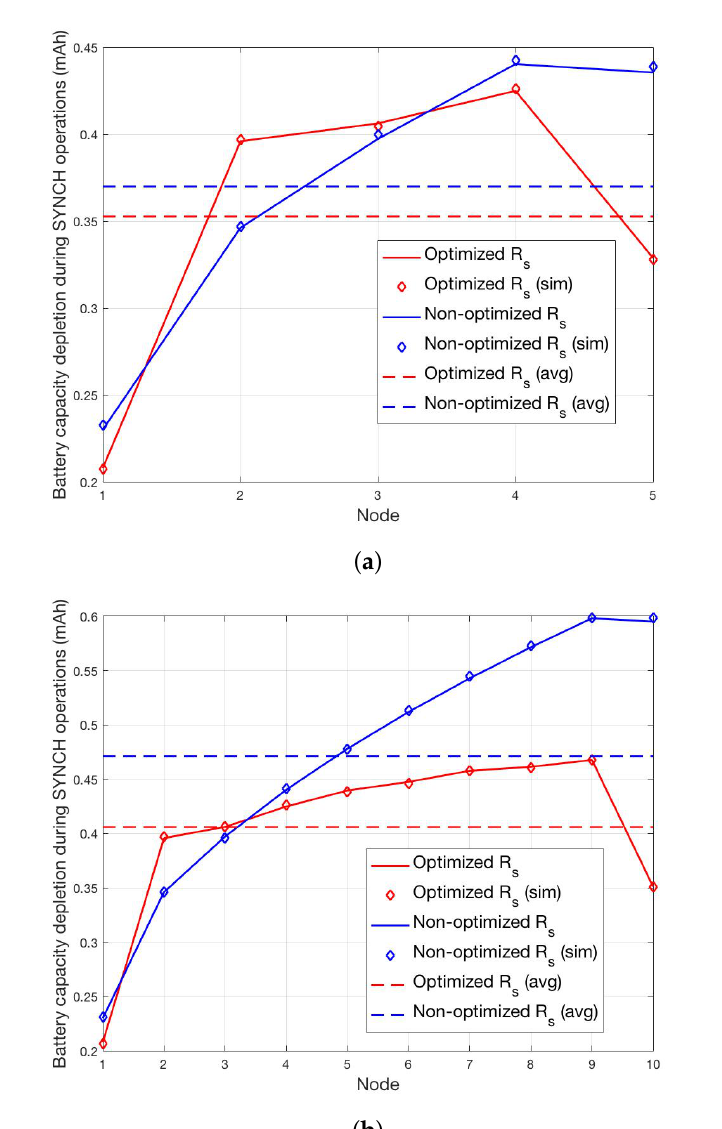
Figure 8. Per-node and average battery capacity depletion during SYNCH operations for the optimized and non-optimized schemes for N = 5 ( a ) and N = 10 ( b